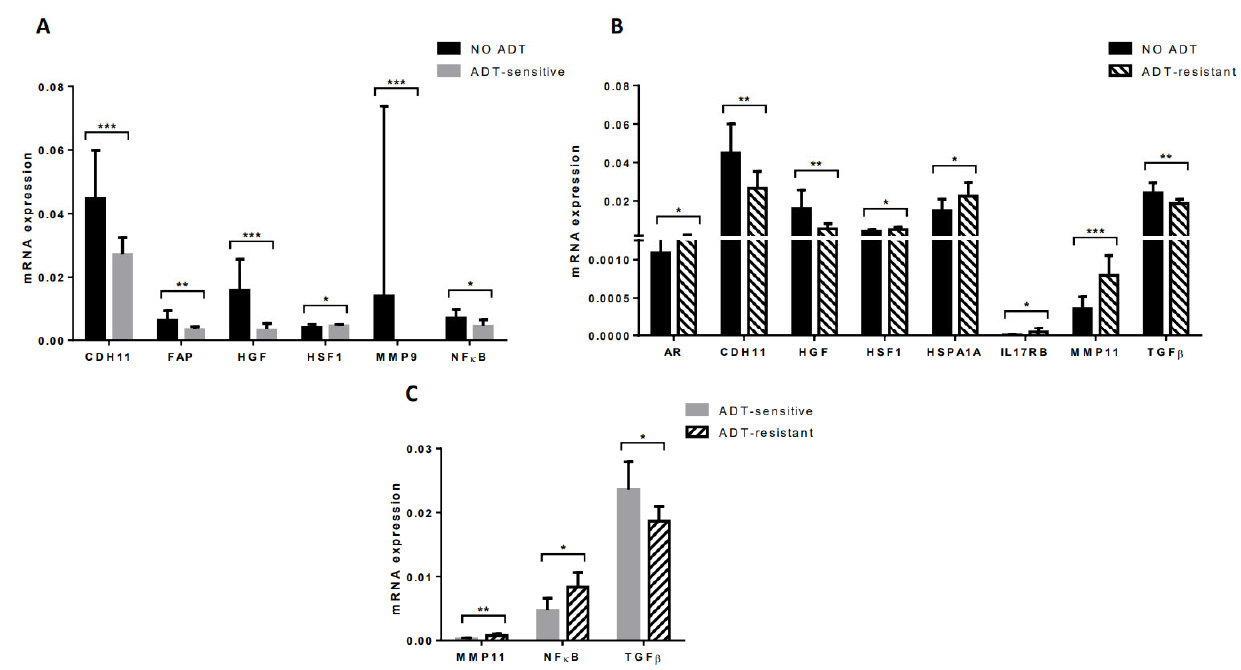
Figure 6. Gene expression of stromal factors by CAFs from prostate carcinoma of patients under androgen deprivation therapy. No ‐ ADT compared with ( A ) ADT ‐ sensitive and ( B ) ADT ‐ resistant, and ( C ) ADT ‐ sensitive compared with ADT ‐ resistant. * p ≤ 0.05; ** p < 0.01; *** p < 0.001.